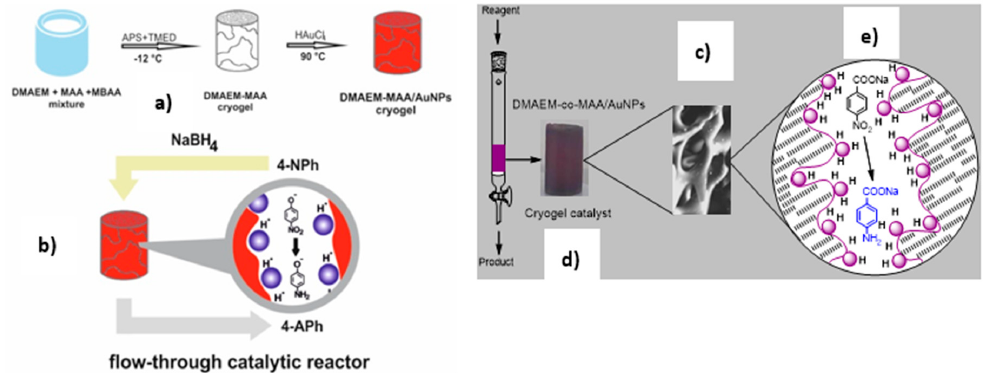
Figure 7. Fabrication of macroporous amphoteric cryogel based on N,N-dimethylaminoethyl metacrylate and methacrylic acid (DMAEM-co-MAA) with immobilized AuNPs ( a ) and schematic representation of monolith flow-through catalytic reactor used for hydrogenation of 4-NP ( b ) and p-NBA ( c ) over DMAEM-co-MAA / AuNPs catalysts. The violet colored sample corresponds to macroporous cryogel DMAEM-co-MAA containing AuNPs ( d ) while the violet dots are schematic image of AuNPs ( e ) in cryogel pores (Reprinted from